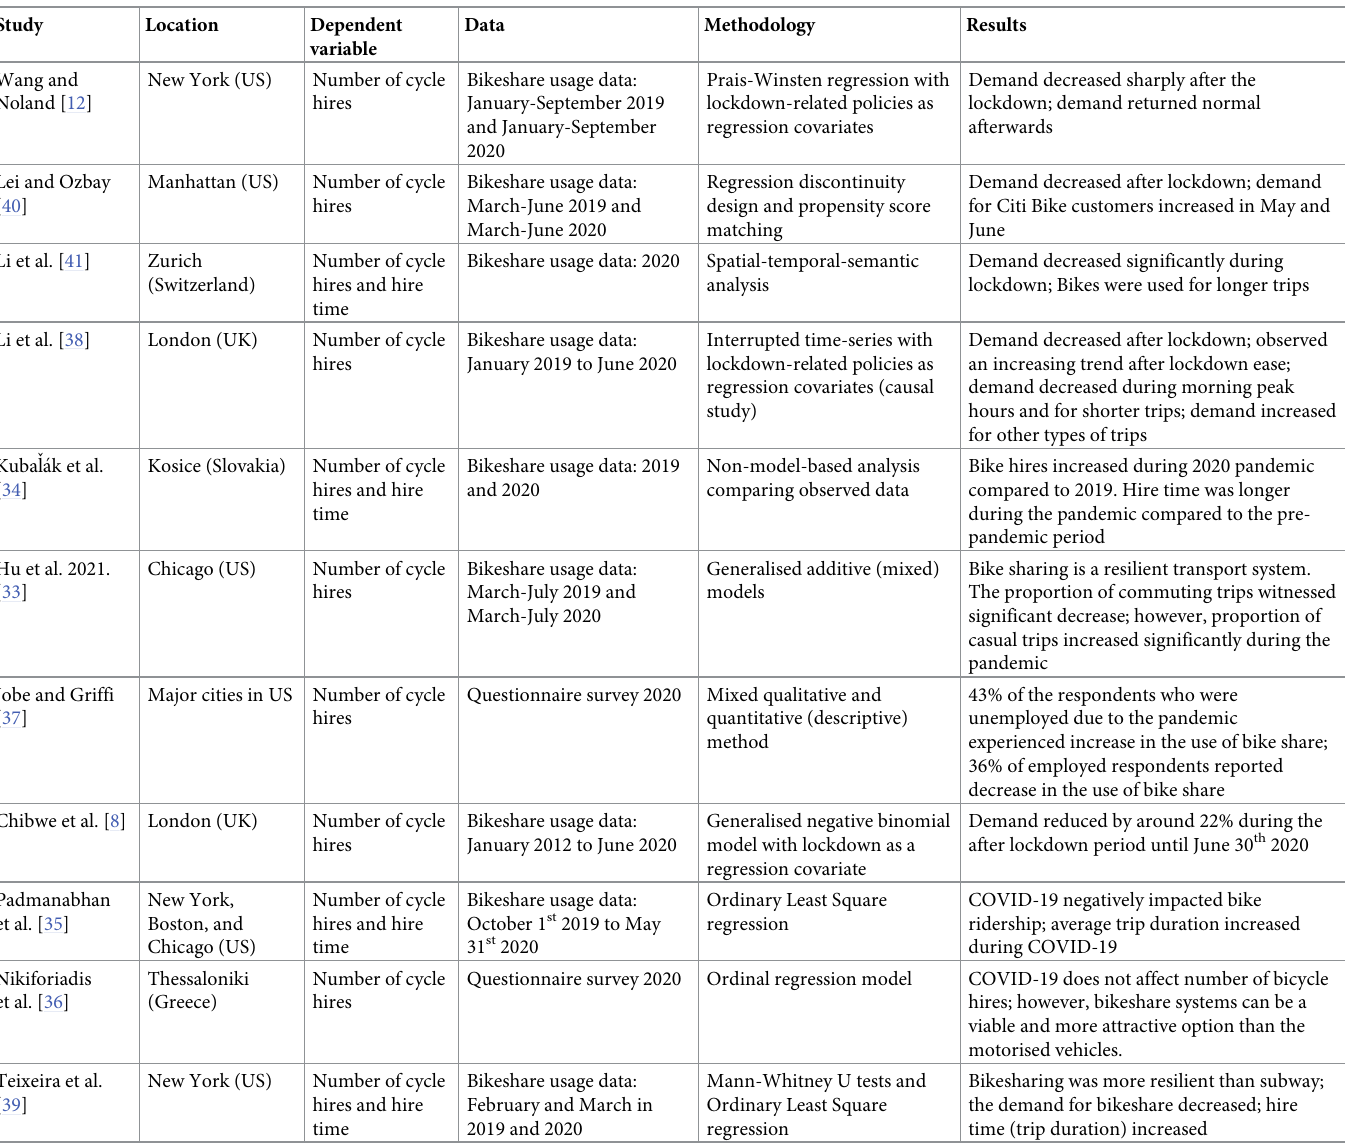
Table 1. Summary of relevant